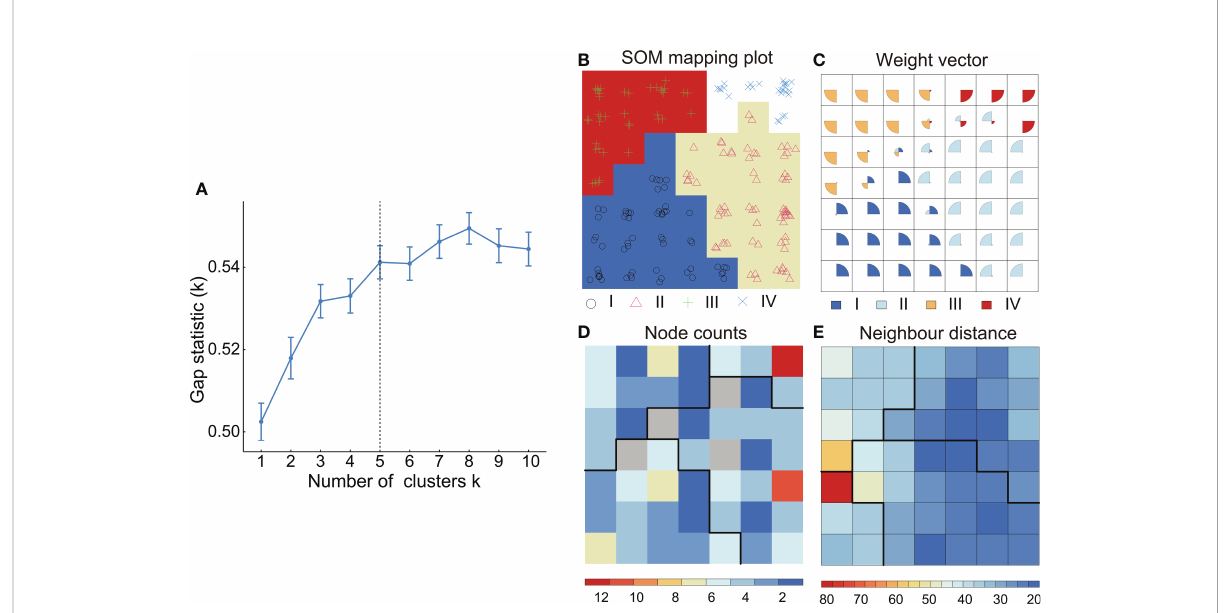
FIGURE 2 Chemotype classi fi cation by K-Means cluster and SOM cluster. (A) Number of clusters K via the K-means gap statistic. (B) Topological mapping plot of the SOM cluster. (C) Distribution patterns of the samples and variables of the SOM cluster. (D) Variable allocations in each grid node of the SOM cluster. (E) Distance of neighboring grid nodes of the SOM